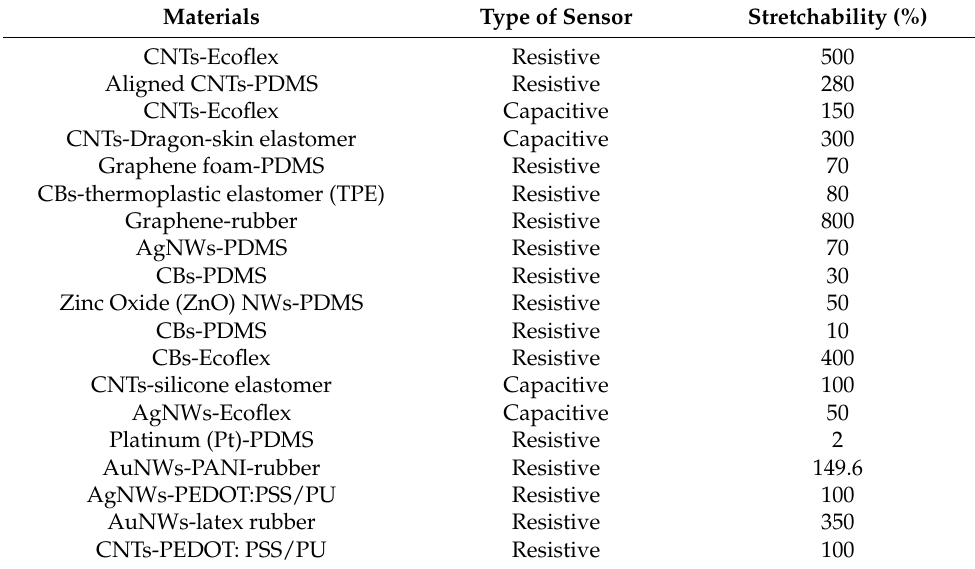
Figure 1. Schematic illustration of the fabrication of AgCNT biocomposite thin films and the assembly of the corresponding piezoresistive wearable sensor. Reproduced with the permission of Reference [8]. Copyright 2021 Elsevier. Table 1. Materials utilized in the fabrication of stretchable strain sensors (Based on Reference [5]).